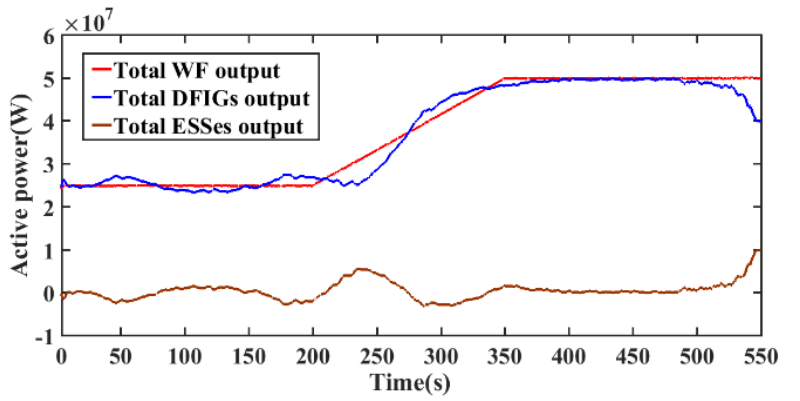
Figure 19. Active power output of wind farm.